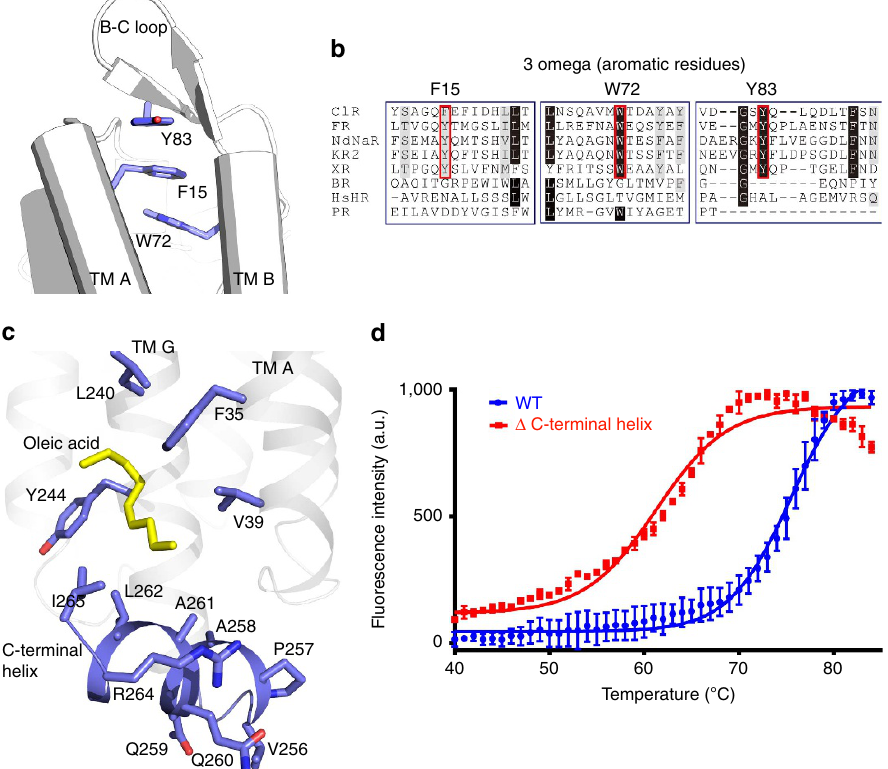
Figure 2 | Structural features of ClR. ( a ) 3 omega motif of ClR formed by p -stacking interactions of the side chains of aromatic residues in TM A (F15), TM B (W72) and B–C loop (Y83). ( b ) Sequence alignment around the 3 omega motif. Conserved aromatic residues forming the 3 omega motif are indicated with red open rectangles. ClRs from N. marinus and Fulvimarina pelagi (FR), sodium-pumping rhodopsins from Nonlabens dokdonensis (NdNaR) and Dokdonia eikasta ( Krokinobacter eikastus ) (KR2), xanthorhodopsin (XR), BR, HR and proteorhodopsin (PR). Identical and similar residues are highlighted in black and grey, respectively. ( c ) Interaction between the C-terminal helix (blue) and oleic acid (yellow). Hydrophobic residues in TMs A and G, which interact with the oleic acid are also depicted in blue. ( d ) Fluorescence thermal stability profiles of wild-type (WT) and D C-terminal helix ClRs. Tm values are 75 (cid:2) C for WT and 61 (cid:2) C for D C-terminal helix ClR. The curves are representative of three experiments and the error bars represent the mean ± s.d. a.u., arbitrary units.